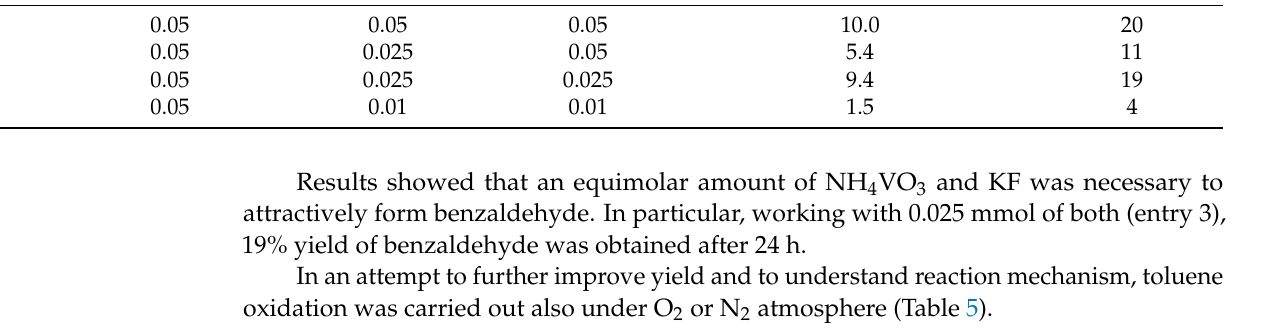
Table 4. Toluene oxidation in biphasic system (V = 20 mL; PhCH 3 :H 2 O 1:1 v/v ), pH = 1, 24 h, T = 25 ◦ C. Entry